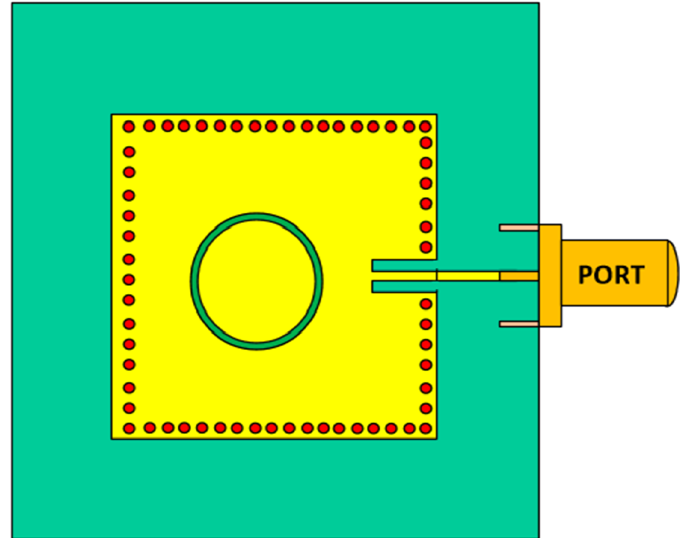
Figure 28. The picture of the SIW resonators.